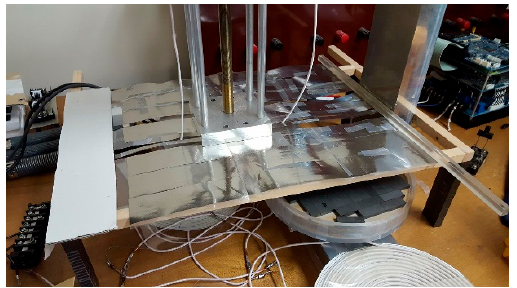
Figure 6. Hybrid intercore coil.